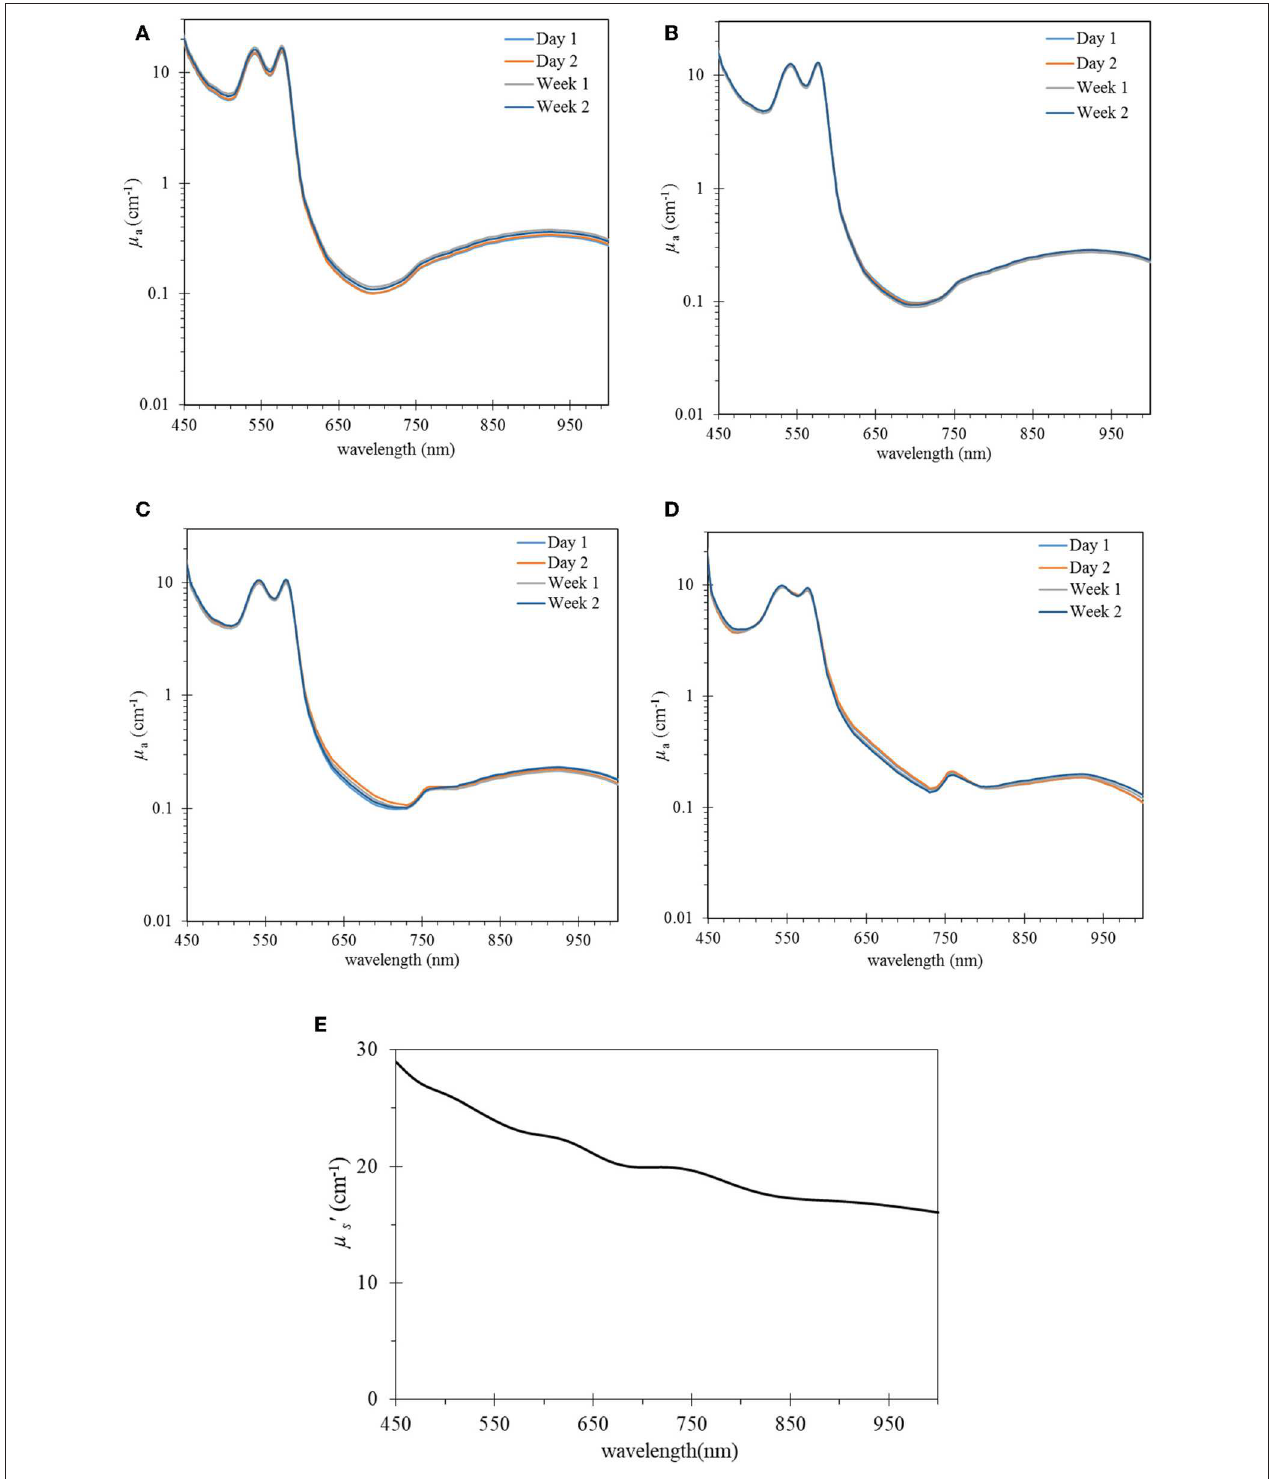
FIGURE 2 | µ a spectra over time of four control phantoms (A) hemoglobin without yeast (Ctr.HbY0), (B) with yeast 5% (Ctr.HbY5), (C) with yeast 10% (Ctr.HbY10), (D) with yeast 15% (Ctr.HbY15). Hemoglobin concentration in all phantoms was kept constant at 7 mg/ml and µ s ’ spectrum of baseline microsphere 0.73% w/v (E) .